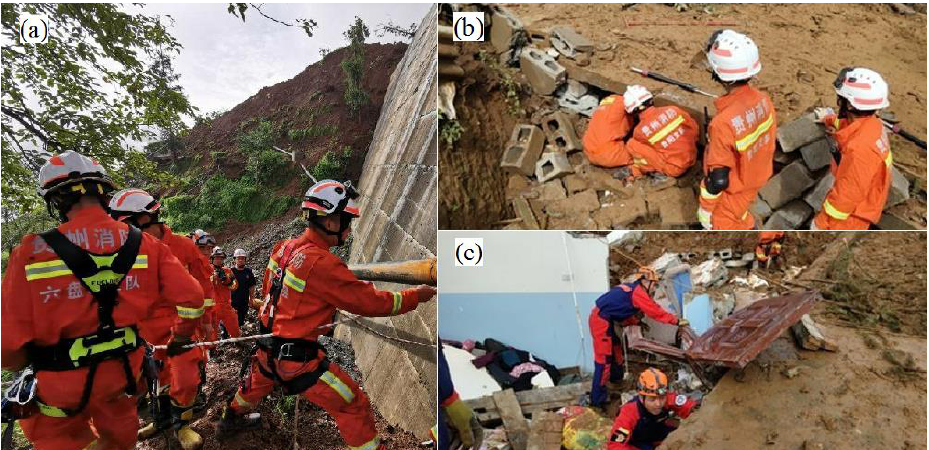
Figure 6. Rescue activities ( a ) Firefighters clearing a barrier (Source: http://www.chinanews.com) ( b ) Firefighters rescuing people from buried houses, and ( c ) Rescue team rescuing people from buried houses (Source: http://www.360kuai.com/ (b) and (c))